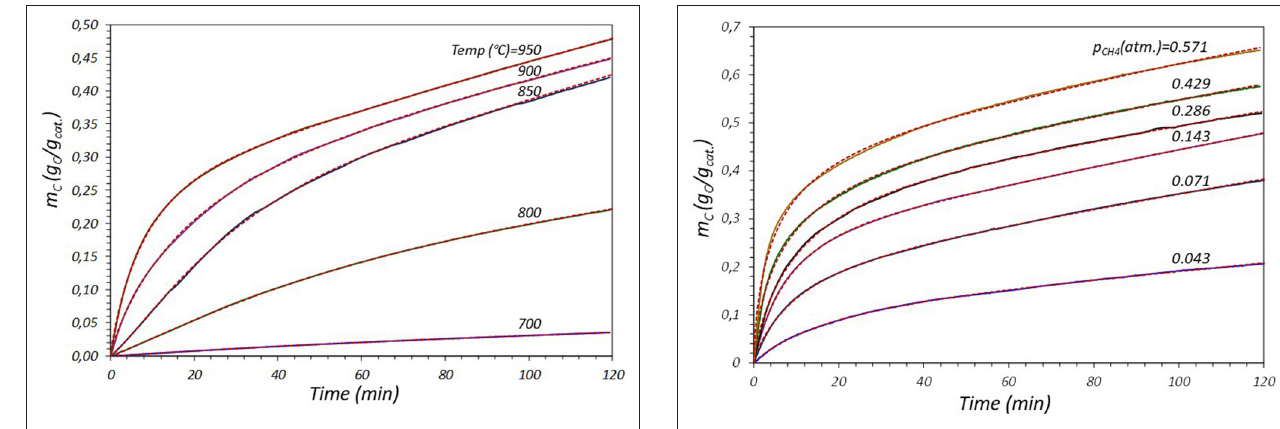
FIGURE 6 | Evolution of carbon content along time. Influence of reaction temperature. Red dotted lines: Model prediction.